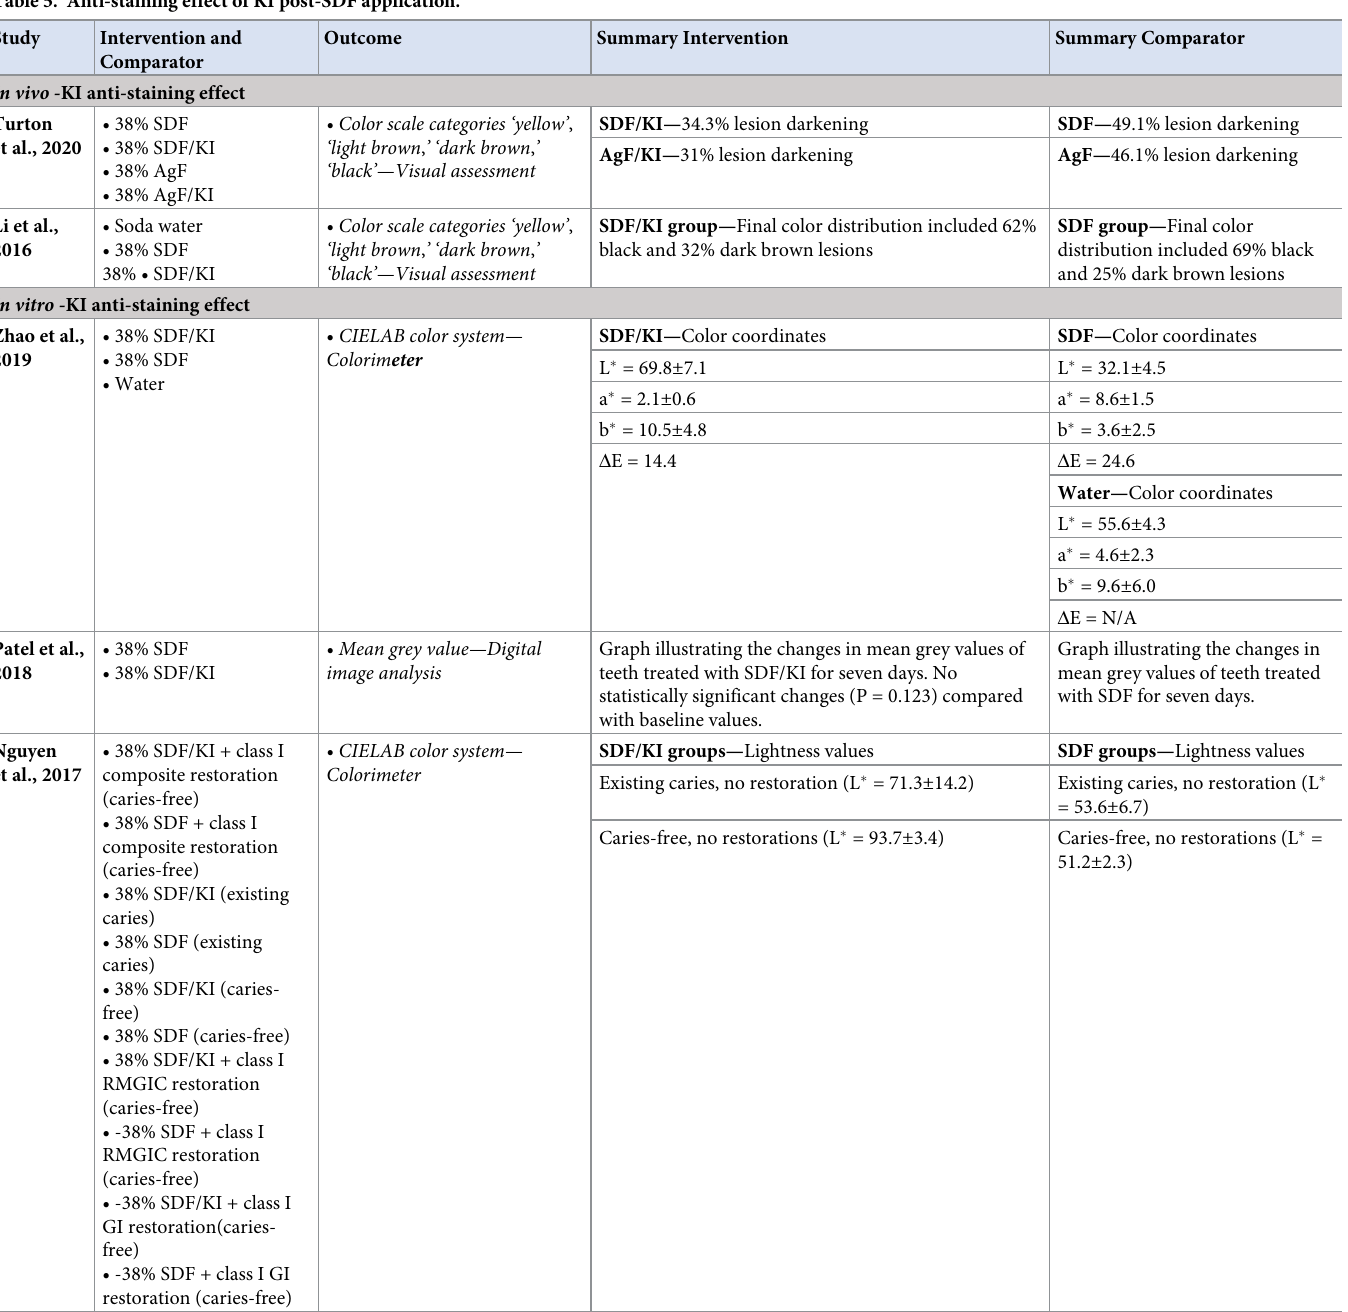
Table 5. Anti-staining effect of KI post-SDF application.